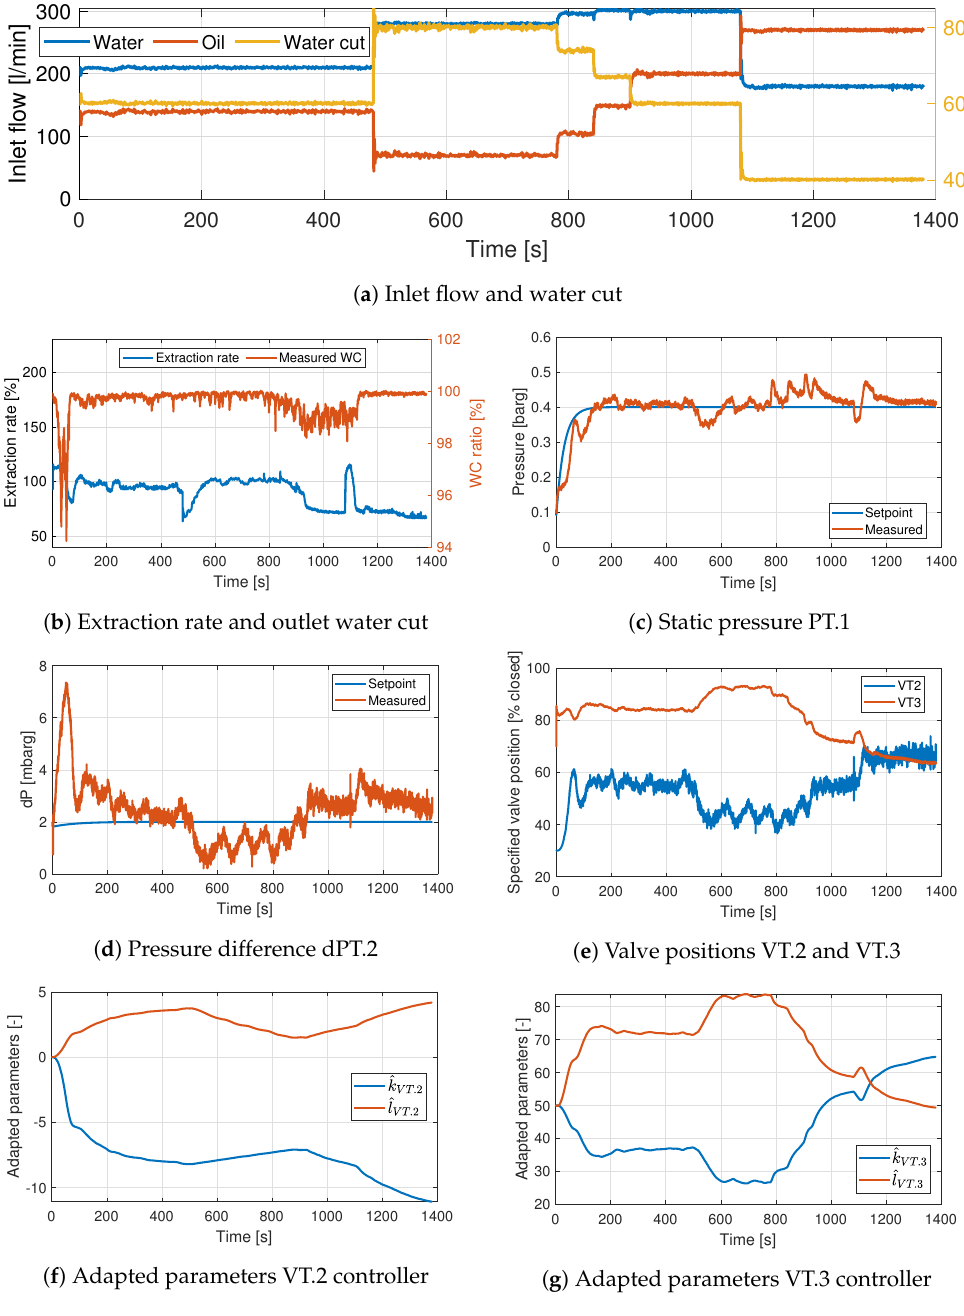
Figure 12. Experiment 6. MRAC on VT.2 and VT.3 with VT.2 controlling dPT.2 and VT.3 controlling PT.1, as recommended by the RGA